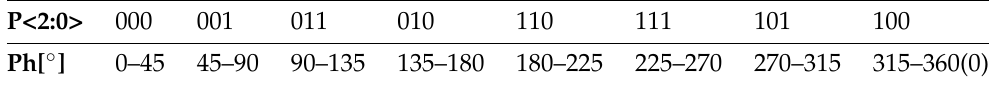
Table 1. Higher three bits coding to P<2:0>.